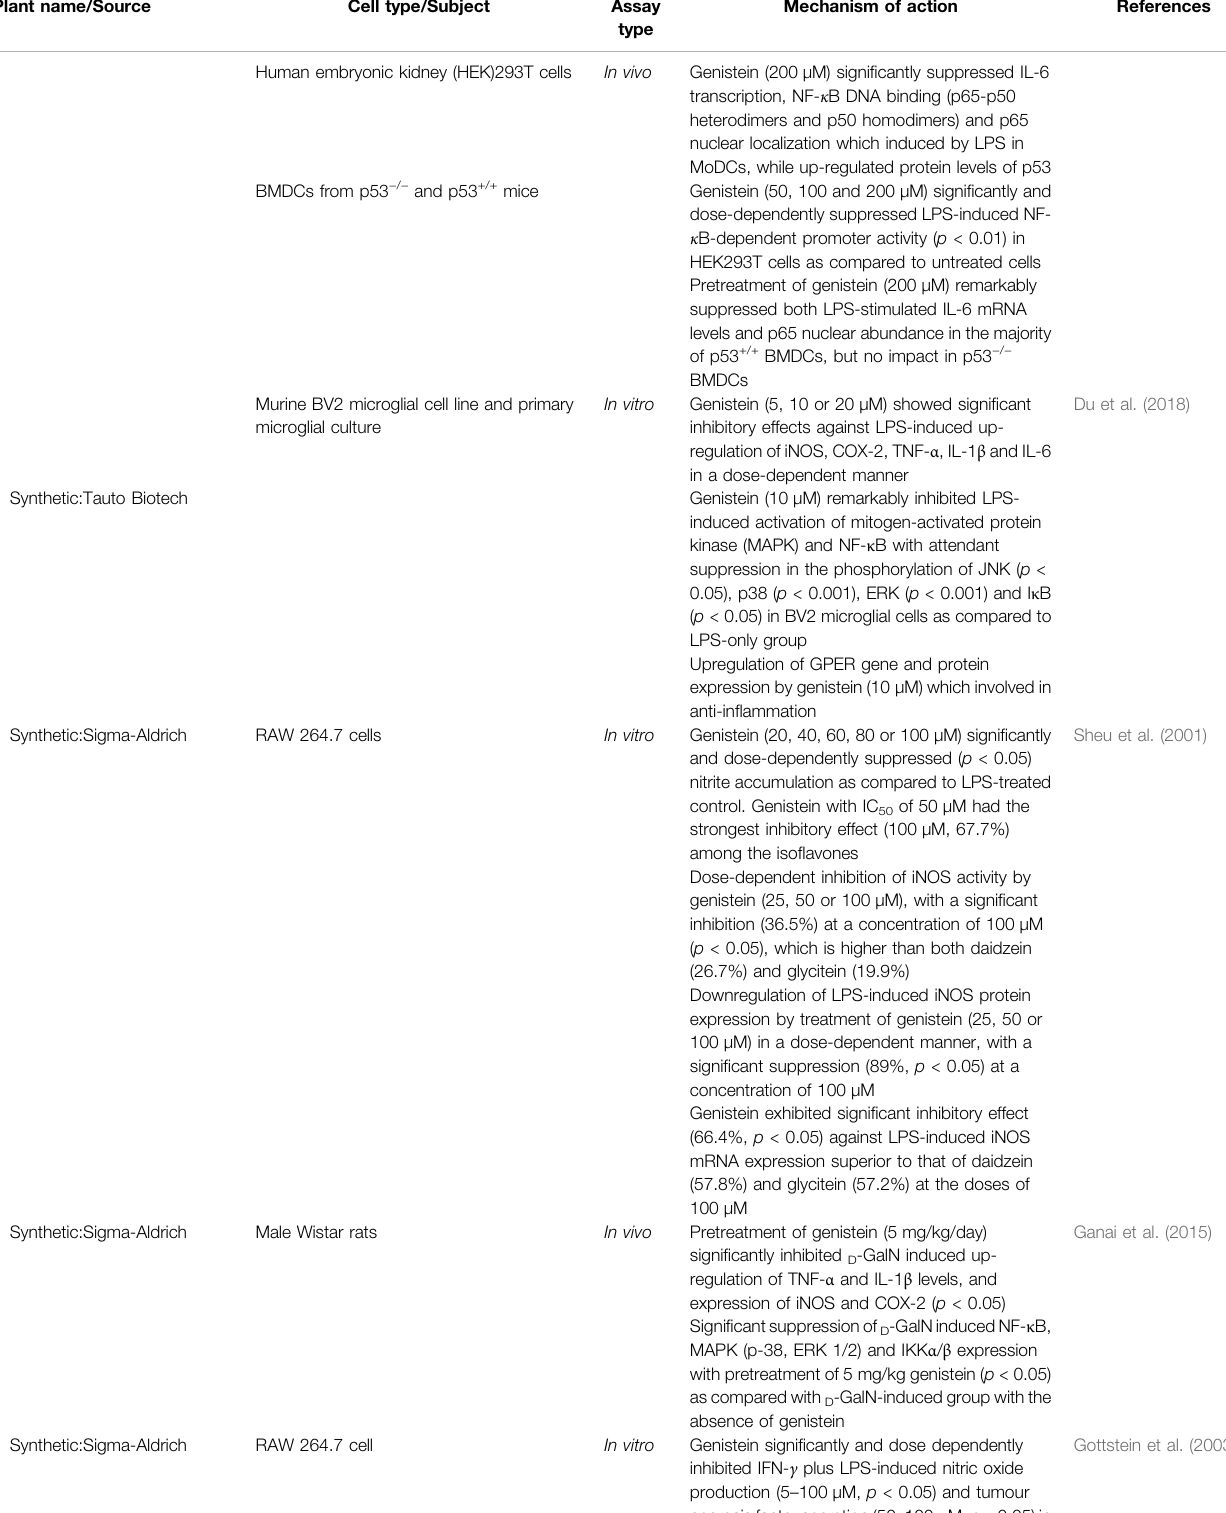
TABLE 1 | ( Continued ) Genistein with potent anti-in fl ammatory